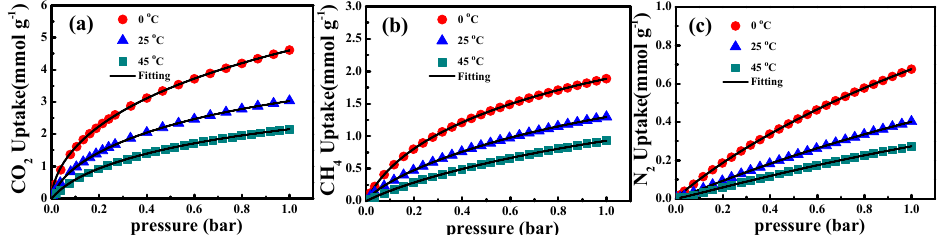
Figure 7. Adsorption isotherms of ( a ) CO 2 , ( b ) CH 4 , and ( c ) N 2 on ACSs-N. The marker points represent the experimental data, while the black solid lines correspond to Langmuir − Freundlich equation fittings. Table 3. Equation parameters for the Langmuir − Freundlich isotherm model on ACSs-N. Adsorbate Temp. (°C)